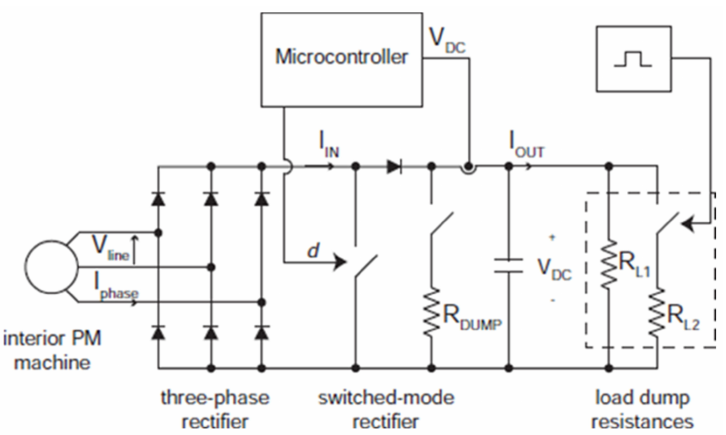
Figure 32. Closed-loop test for the PM alternator with switched-mode regulator (SMR) [29]. Figure 33 below represents the output power for the alternator using